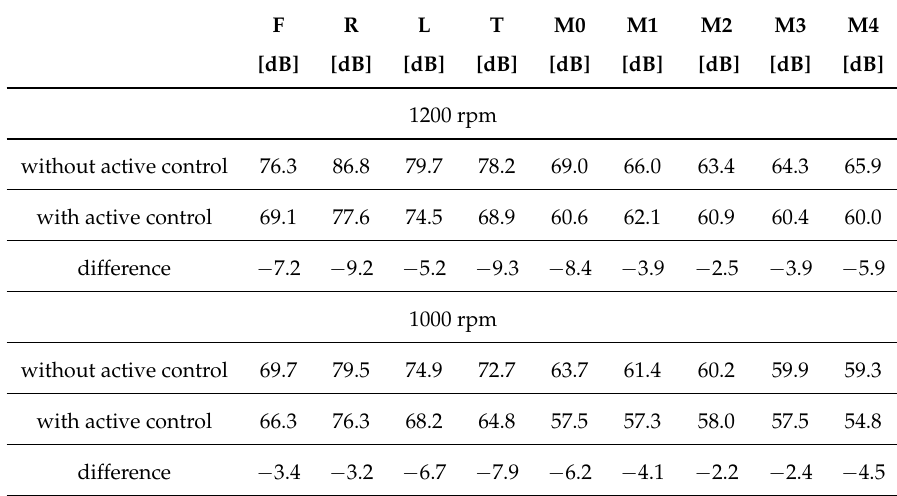
Table 2. The sound pressure levels at all error and monitoring microphones for a different spinning speed without control and with active noise control enabled (F—front, R—right, L—left,